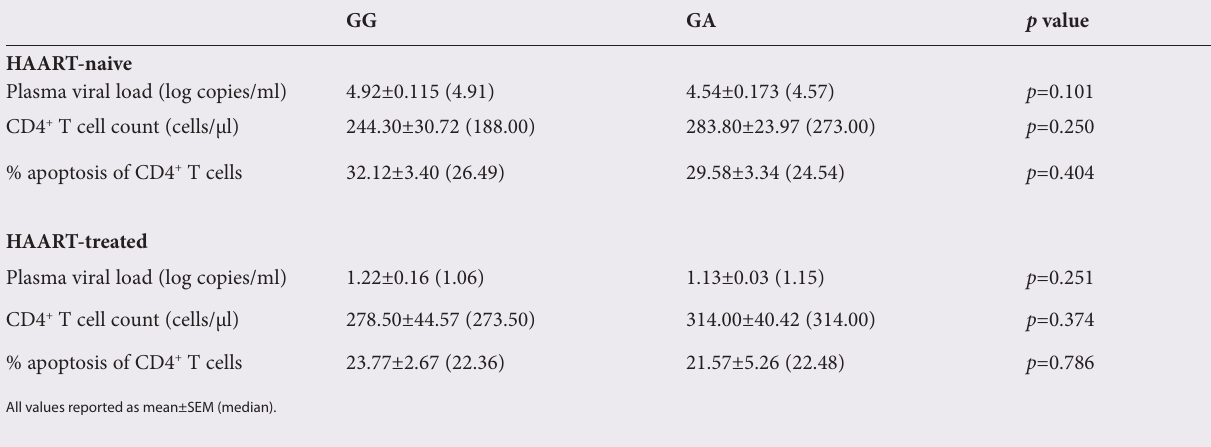
Table 4. Markers of HIV progression in the -308 GG and -308 GA genotypes in the HAART-naive and HAART- treated groups GG